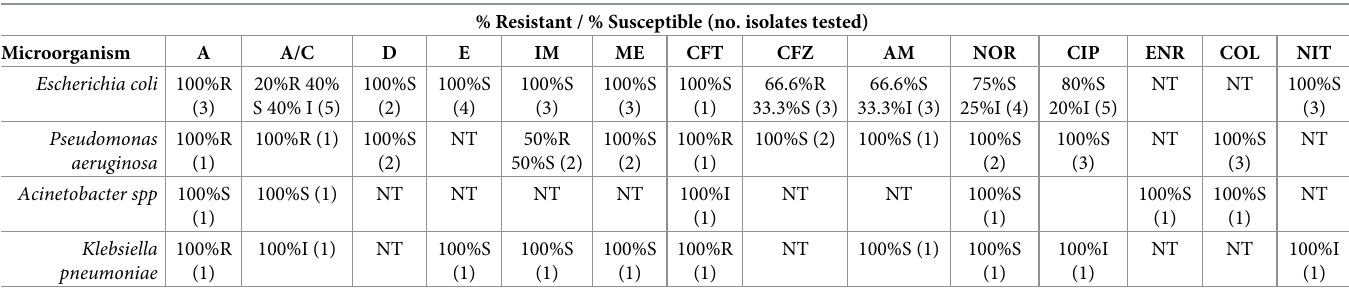
Table 2. Antibiogram results for the Gram-negative cultured bacteria. % Resistant / % Susceptible (no. isolates tested)